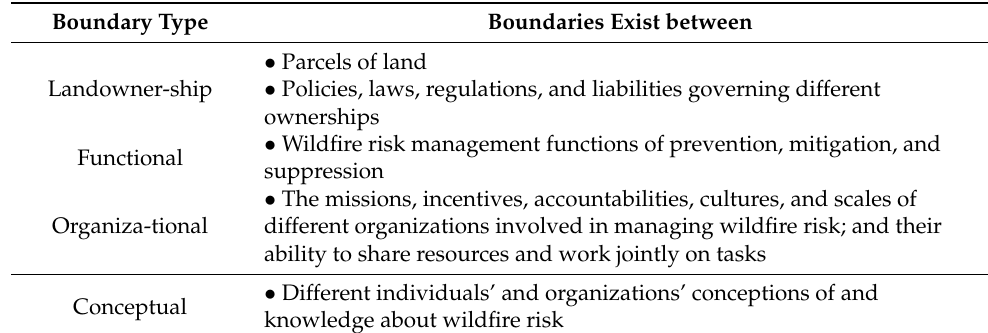
Table 1. Summary of major types of boundaries in wildfire